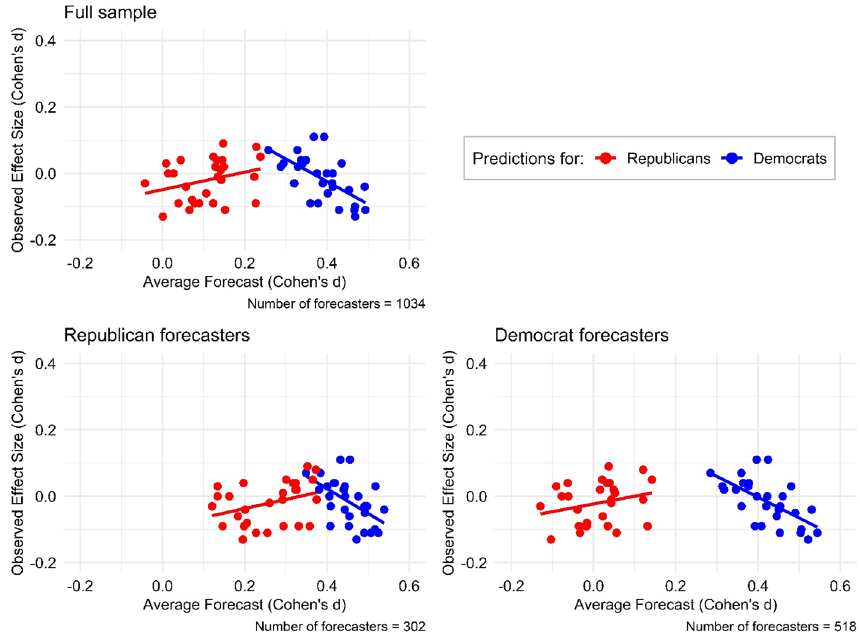
Figure 1. Correlations between forecasted and observed effect by political party of forecaster and nudgee. Note : Correlation between observed and predicted effect sizes (in terms of Cohen’s d) for the 56 forecasting questions in the forecasting survey, differentiated by color for forecasts of Republican (red) and Democrat (blue) nudgees. The top panel includes the full sample of forecasters. The bottom panel shows the correlation separately for Democrat and Republican